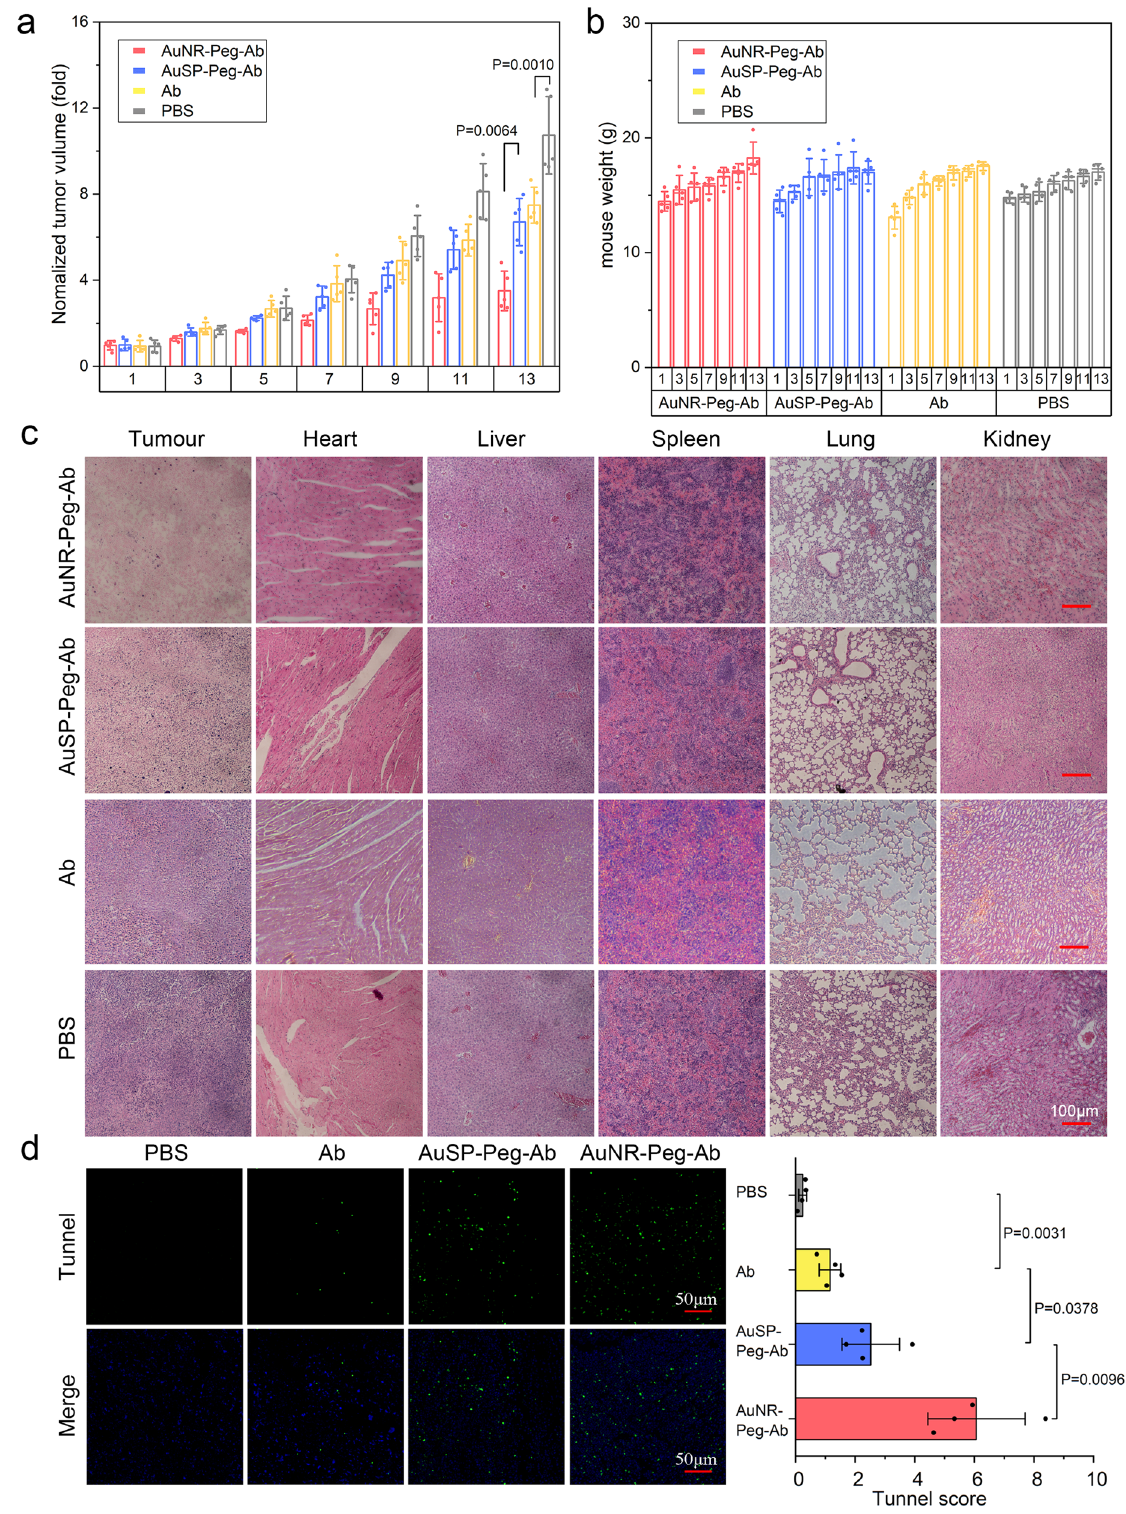
Fig. 7 In vivo evaluation Ab connected nanomaterials in tumor inhibition. a The changes in tumor size during the curing process. Data represent mean ± SD ( n = 5). b The changes in mice body weight during the curing process. Data represent mean ± SD ( n = 5). c Representative images of H&E images of the tumor and other tissue slices stained with H&E. d Tunnel immuno fl uorescence straining detected apoptosis cells. Data represent mean ± SD ( n = 4). Statistical difference was evaluated by one-way ANOVA followed by Tukey ’ s post hoc